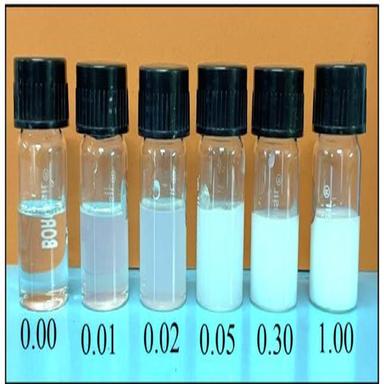
Digital photograph of GLY/x (wt%) ZnO nanofluids (x = 0.00, 0.01, 0.02, 0.05, 0.30, and 1.00).